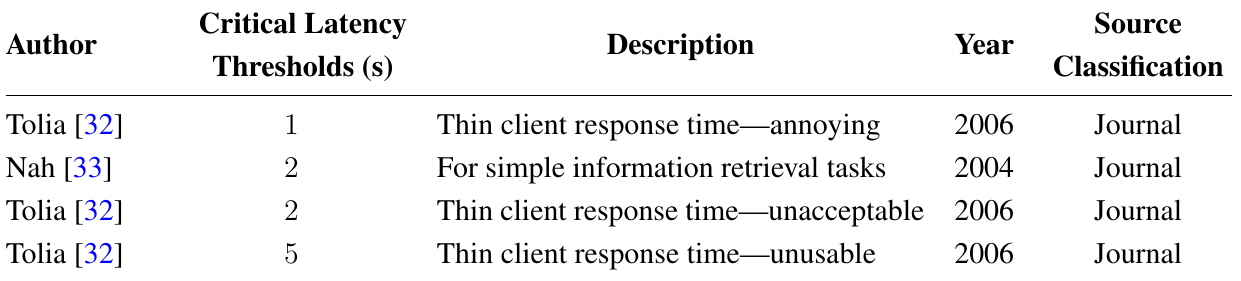
Table 1. Classification of Critical Latency